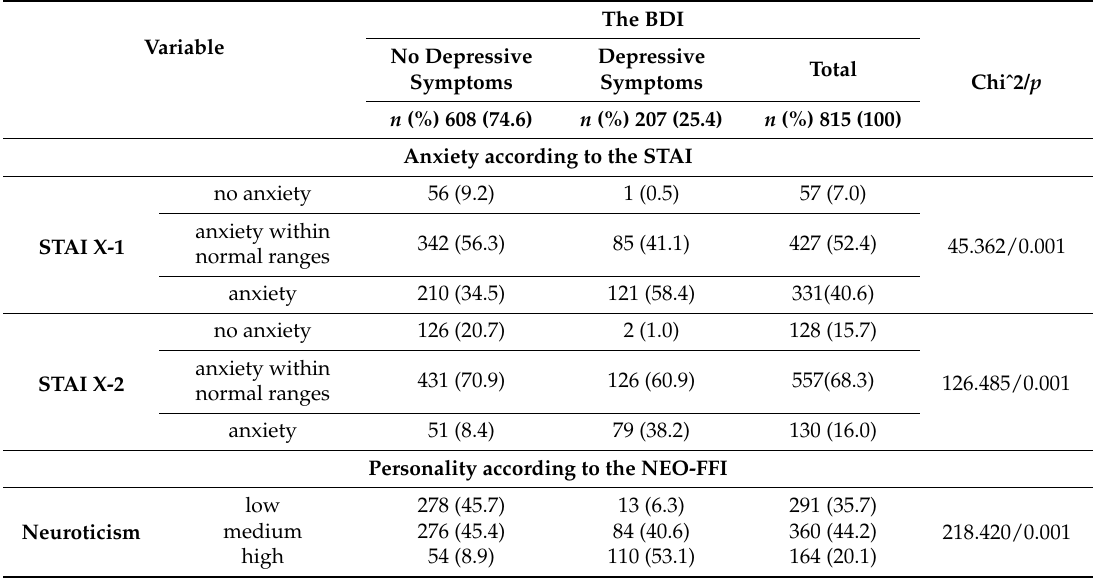
Influence of anxiety and personality on depressive symptoms in the pre-, peri-, and postmenopausal